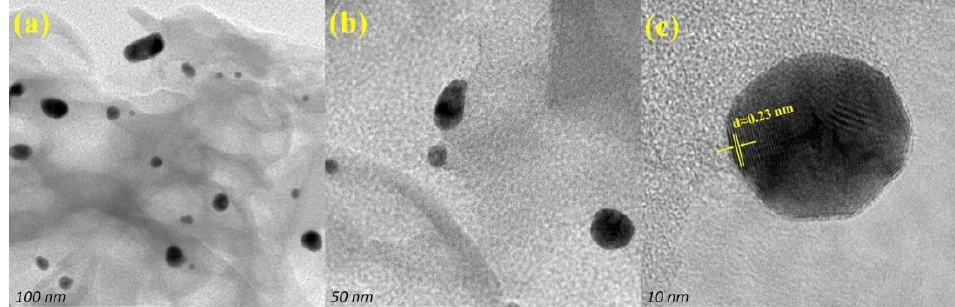
Figure 5. HRTEM images of CNN/Au nanocomposite with different magnitudes of 100 nm ( a ), 50 nm ( b ), and 10 nm ( c ). 50 nm ( b ), and 10 nm ( c